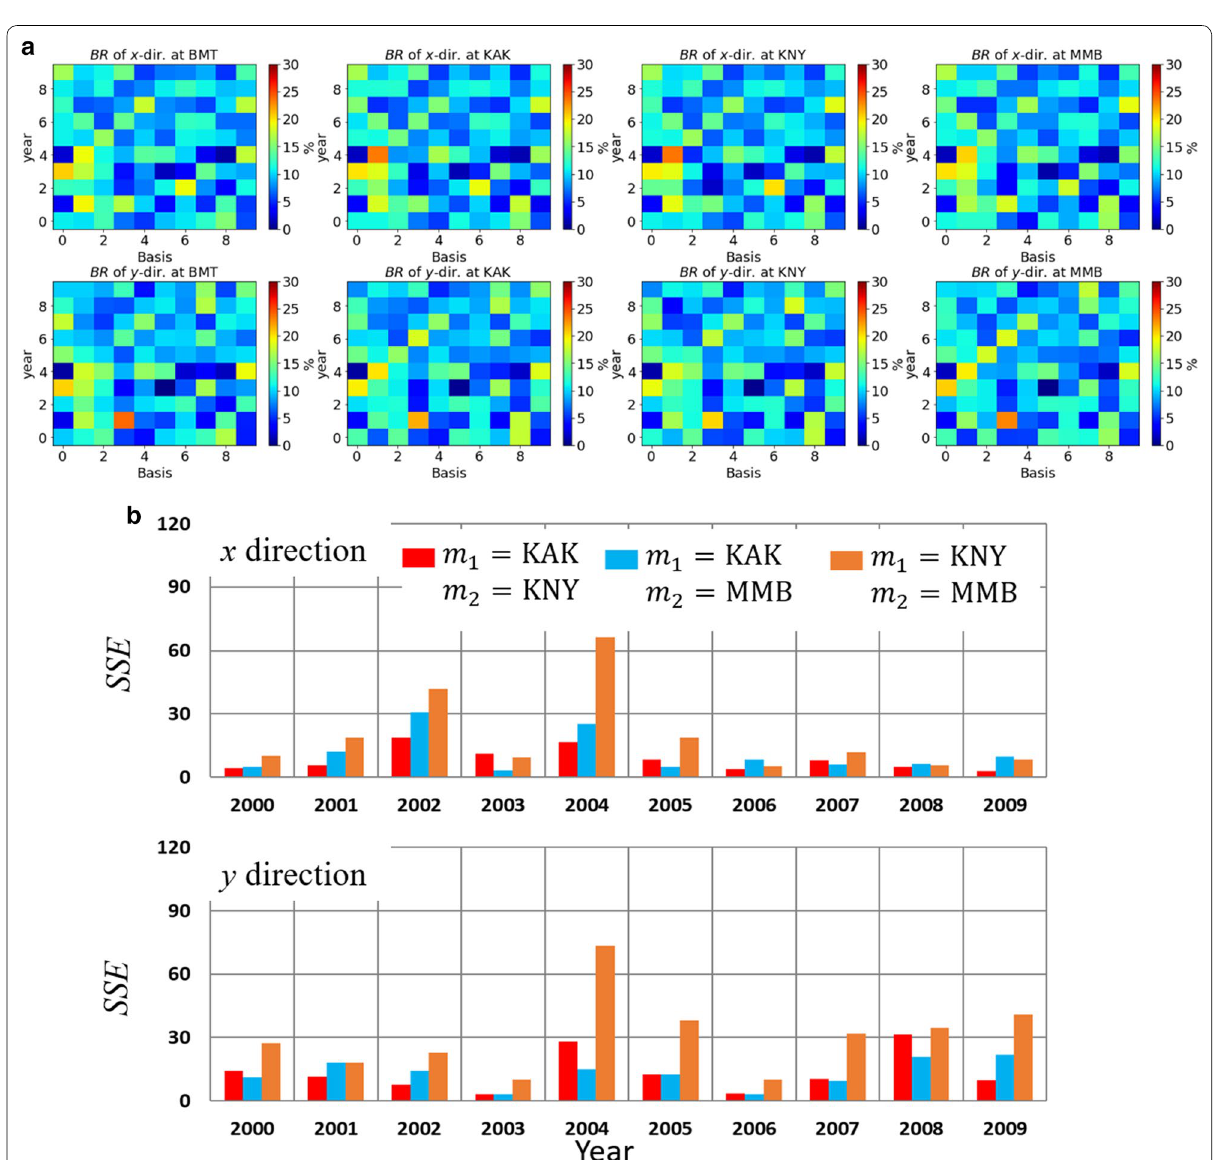
Fig. 8 Results obtained applying MC‑NMF to geomagnetic spectrograms from four observatories. a BR at 9/30,720 Hz (left: BMT, left mid: KAK, right mid: KNY, and right: MMB). The uppers show BR of the x component and the lowers show BR of the y component. The vertical axis denotes years during 2000–2009 (the standard is 2000), and the horizontal axis denotes IDs of Basis vectors. b The SSE ( KAK,KNY ) (red), SSE ( KAK,MMB ) (light blue), and SSE ( KNY,MMB ) (orange). The upper denotes the SSE of the x component and the lower denotes the SSE of the y component. The vertical axis denotes SSE and the horizontal axis denotes